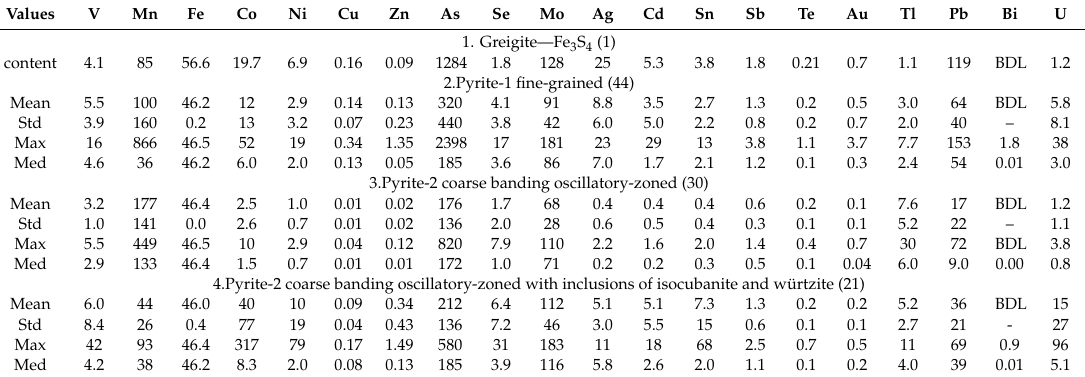
Table 3. Trace element contents in sulfides of third style pyrite crusts. Pobeda vent site. LA-ICP-MS data in ppm. Fe Cu. Zn are in wt. %.